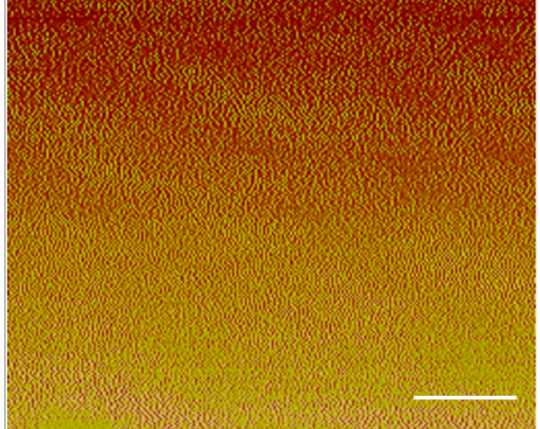
Figure 5. Wide angle X-ray diffraction (WAXD) profiles of P3-PU and P7-PU .